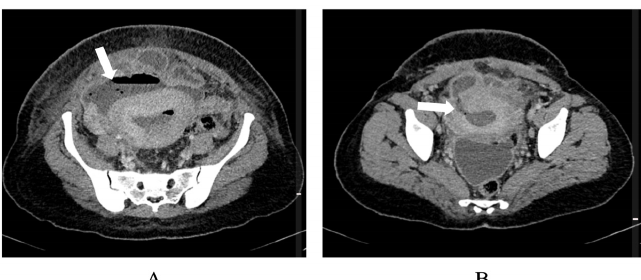
Figure 3. Computed tomography demonstrating a) fluid collection anterior to the uterus that communicates with the endometrial cavity and b) defect in the anterior wall of the uterus. Case courtesy of Dr Hidayatullah Hamidi, Radiopaedia.org, rID: